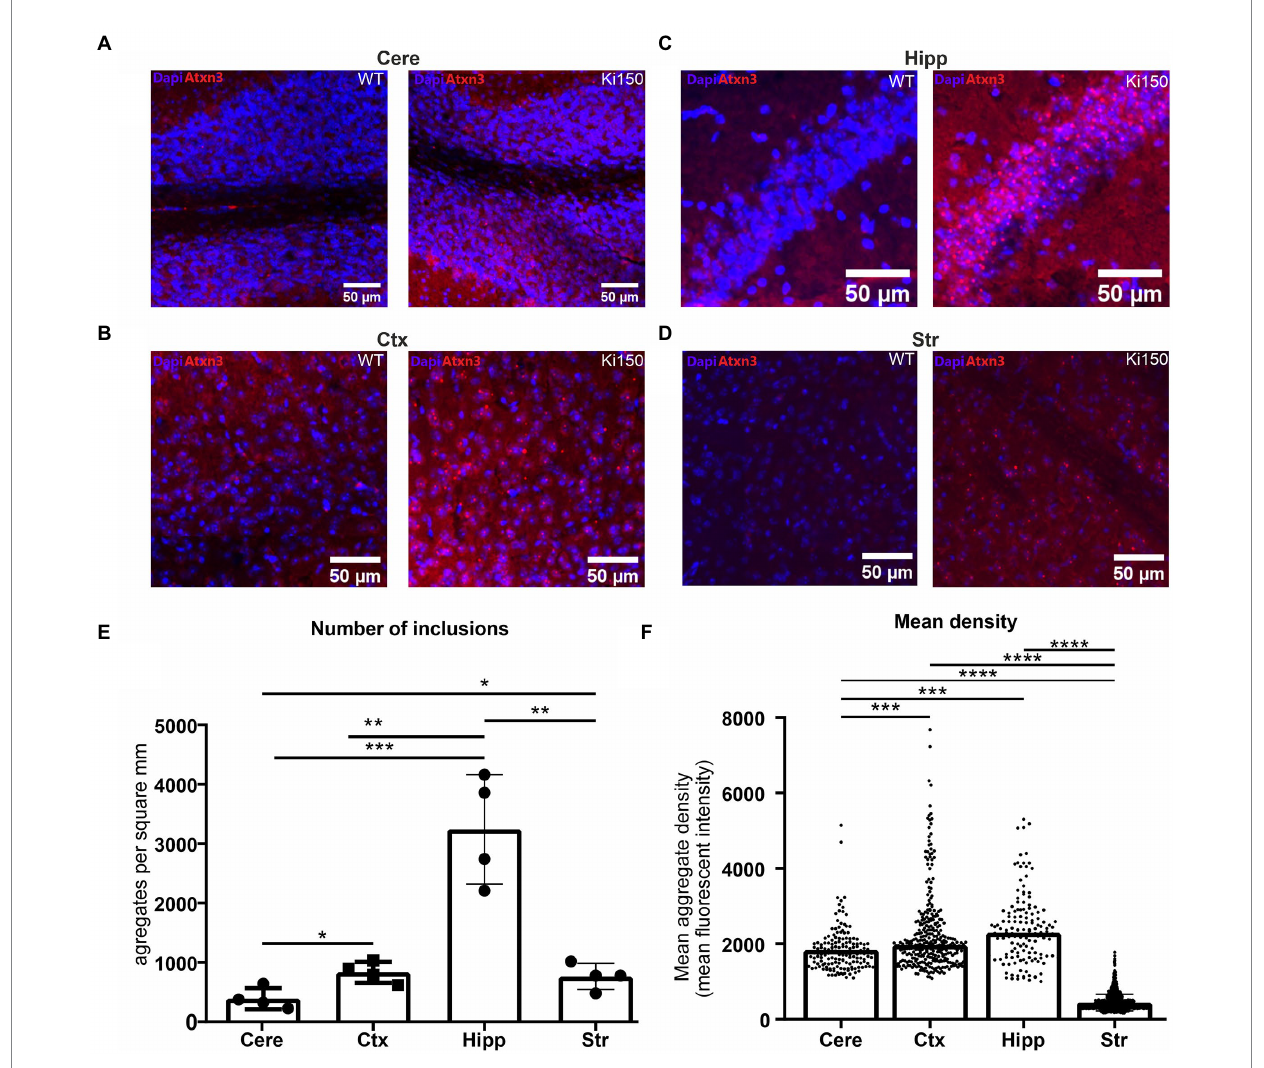
FIGURE 2 Ataxin-3-positive inclusions appear across the whole brain in SCA3 mouse model. (A) cerebellum (cere), (B) cerebral cortex (ctx), (C) hippocampus (hipp) (D) striatum (str). (E) Aggrecount imageJ macro identified about 400 inclusions per square millimeter in cerebellum, 800 inclusions per square millimeter in cerebral cortex, 3,000 inclusions per square millimeter in hippocampus and 760 inclusions per square millimeter in striatum ( n = 4). (F) The density of a single inclusion was also the highest in the hippocampus (median = 2,298) as compared to cortex (median = 1969), cerebellum (median = 1727), and striatum (median = 0.382). Two-sample t -test (* p < 0.05, ** p < 0.01, *** p < 0.001, **** p < 0.0001), error bars: SEM ( n = 4 indicates 4 brains/4 mice. Per brain, 3 slices as technical replicates were used. Total number of 12 images were used for estimation of each brain